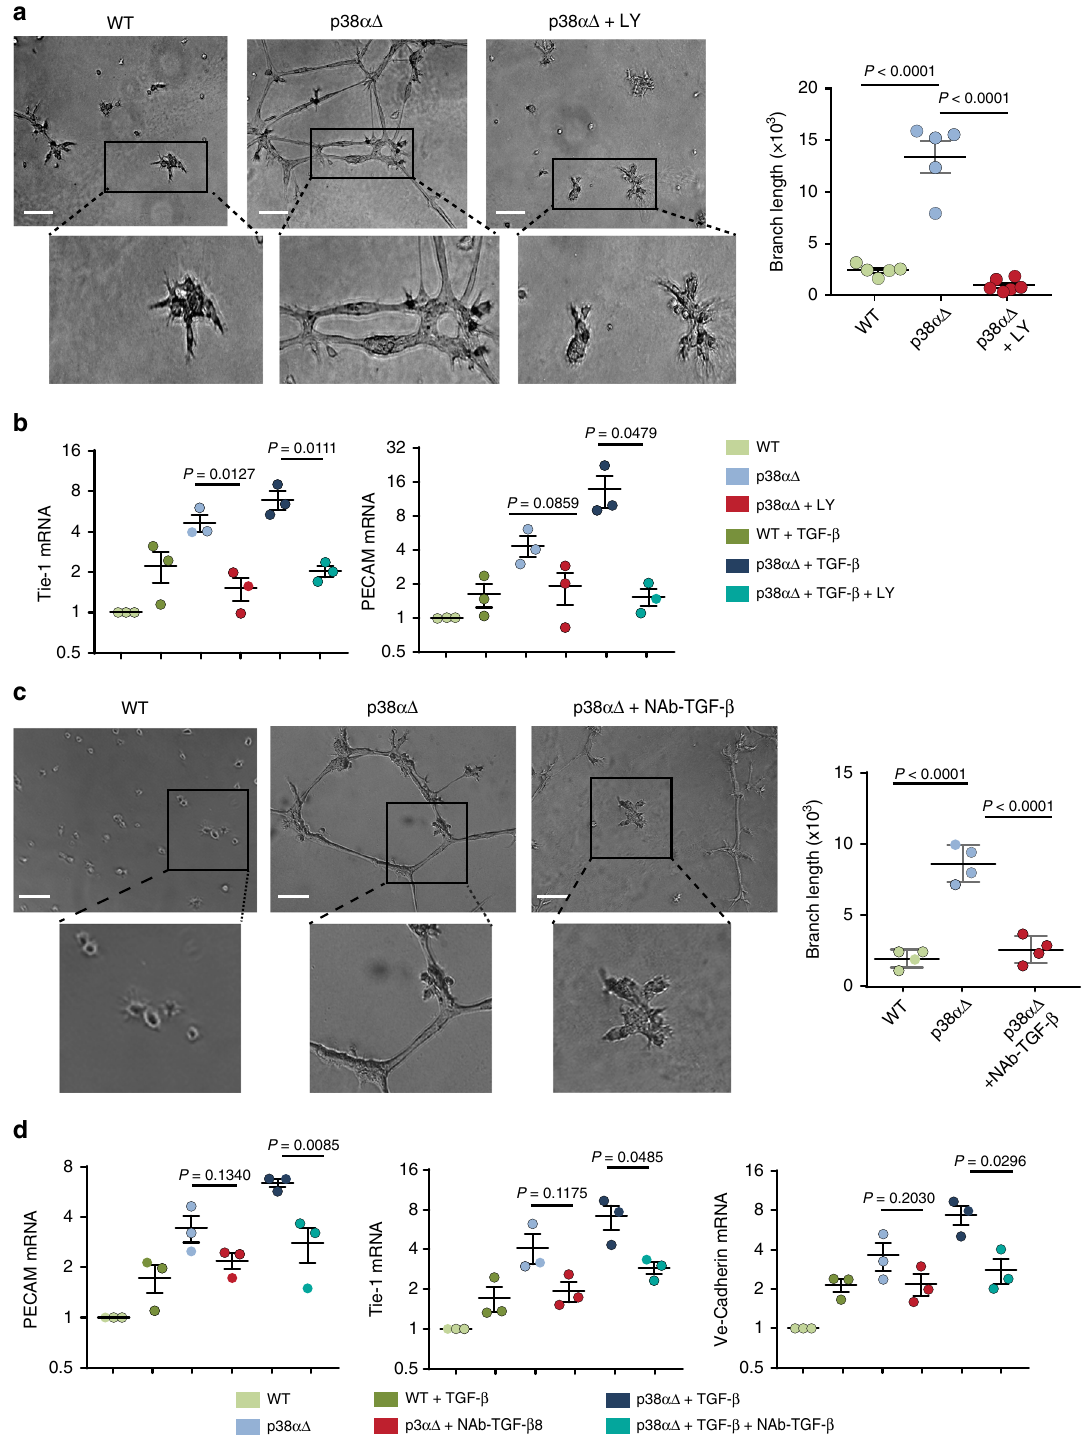
Fig. 5 TGF- β signaling controls the conversion of p38 α -de fi cient MSCs to endothelial cells. a MSCs were seeded in 0.5% FBS, and treated with the TGF- β inhibitor LY2157299 (LY, 1 nM) as indicated. Tube formation in matrigel was evaluated 10 h later. The histogram shows the quanti fi cation of the branch length per fi eld using ImageJ. Data are mean ± SEM ( n = 5 in WT and p38 αΔ , n = 6 in p38 αΔ + LY). Bars, 100 μ m. b Cells were cultured in 0.5% FBS for 5 days in the presence or absence of TGF- β and/or the TGF- β inhibitor LY, which was added to the medium every 2 days. Relative mRNA expression levels for the endothelial markers Tie-1 and PECAM were analyzed by RT-PCR. Values are graphically represented in log2 scale and show the fold change versus WT. Data are mean ± SEM ( n = 3). c MSCs were treated with TGF- β 1, 2, 3 antibody (2 μ g ml − 1 ) or mouse IgG1, as indicated. Tube formation in matrigel was evaluated 10 h later. The histogram shows the quanti fi cation of the branch length per fi eld using ImageJ. Data are mean ± SEM ( n = 4) Bars, 100 μ m. d Cells were cultured in 0.5% FBS for 5 days in the presence or absence of TGF- β and/or the TGF- β 1, 2, 3 Antibody or mouse IgG1, which was added to the medium every 2 days. Relative mRNA expression levels for the endothelial markers Tie-1, PECAM and Ve-Cadherin were analyzed by RT-PCR. Values are graphically represented in log2 scale and show the fold change versus WT. Data are mean ± SEM ( n =